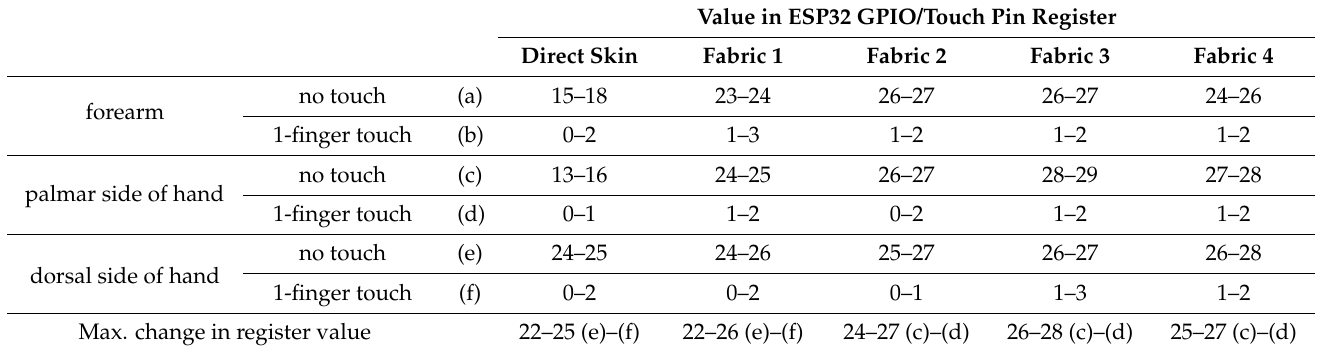
Table 3. Performance of the off-the-shelf FSR for one-finger touch when placed on different